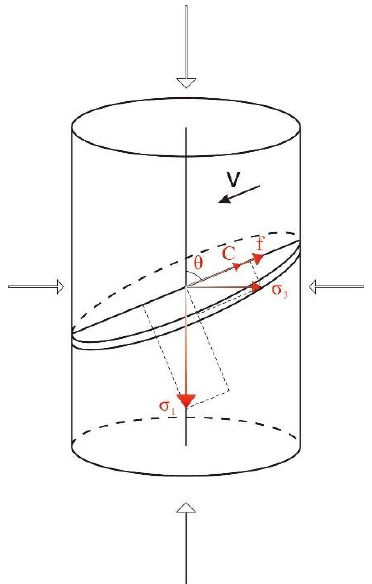
Figure 1. Laminated rock model composed of the lamina and the surrounding rock. Red arrows indicate the decomposition of stress along the lamina surface, where θ indicates the lamina angle, σ 1 indicates the axial stress, σ 3 indicates the confining pressure, C lamina indicates the lamina cohesion, and f indicates the friction force between the lamina surface and surrounding rock.